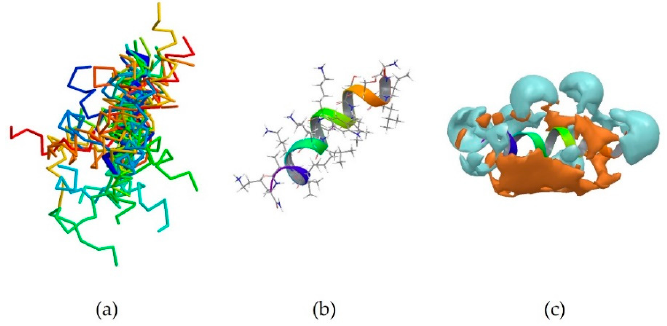
Figure 1. ( a ) Superimposition of all members of cluster 1 onto the backbone of the centroid 5MMK shown in thick blue trace representation. 19 members out of 24 in this cluster assume at least a partial α -helix conformation (thin, coloured α -carbon traces); ( b ) Stick representation of the experimentally-derived conformation of 5MMK. The ribbon shows how the antimicrobial peptide 5MMK assumes an α -helix conformation; ( c ). Side view of the PDB entry 5MMK, highlighting the polar regions of the surface. The hydrophilic part is shown in cyan, whilst the hydrophobic component is displayed in amber.